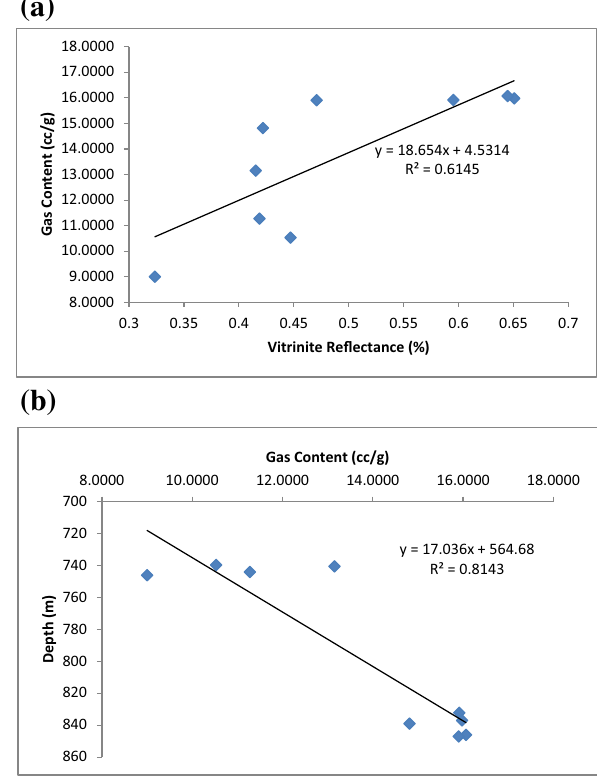
Fig. 4 a Variation in gas content with vitrinite reflectance. b Varia- tion in gas content with